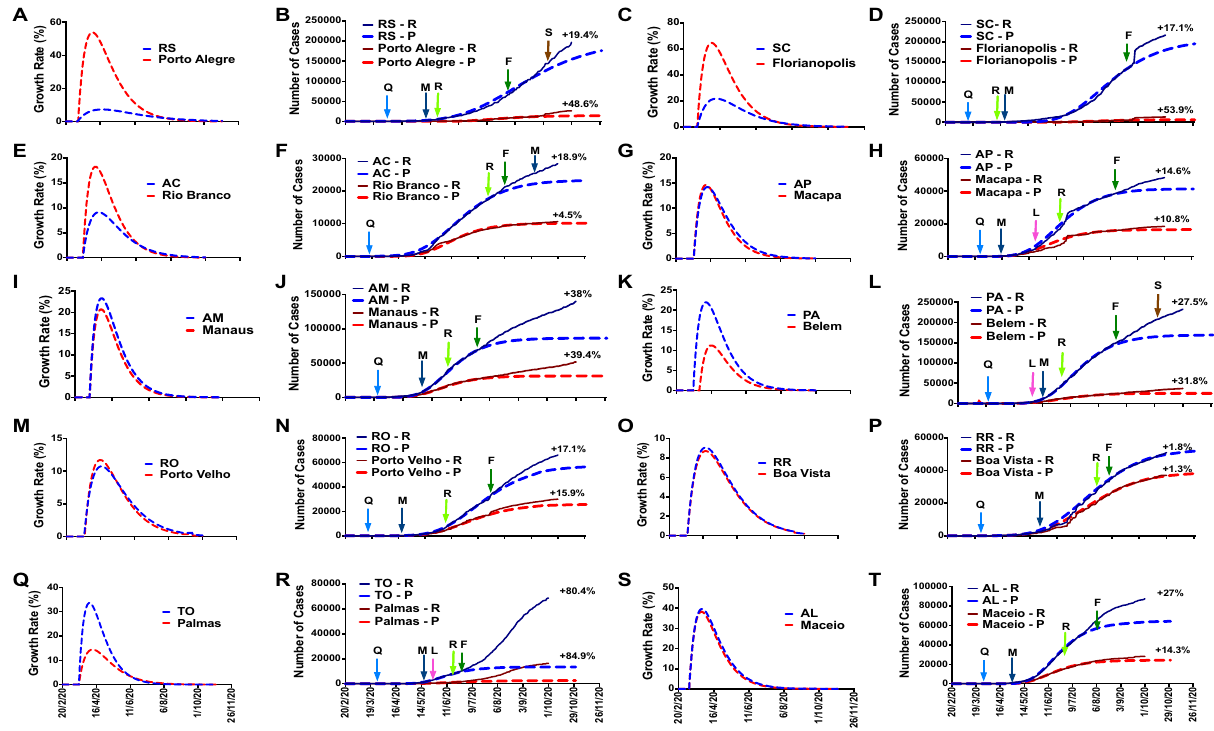
Figure 2. ( A ), ( C ), ( E ), ( G ), ( I ), ( K ), ( M ), ( O ), ( Q ), ( S ): Cumulative COVID-19 cases; and ( B ), ( D ), ( F ), ( H ), ( J ), ( L ), ( N ), ( P ), ( R ), (T): Growth rate of COVID-19 in Rio Grande do Sul (RS), Santa Catarina (SC), Acre (AC), Amapa (AP), Amazonas (AM), Para (PA), Rondonia (RO), Roraima (RR), Tocantins (TO), and Alagoas (AL), respectively, with their respective capitals. − R: reported number; − P: predicted number; Q: quarantine; L: lockdown, M: mask use; R: reopening; F: flexibilization; S: school